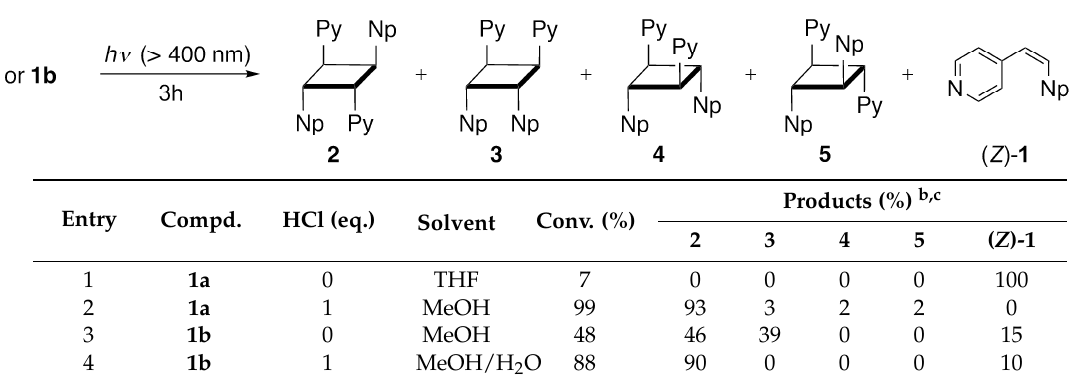
Table 2. Visible-light irradiation of 1a and 1b . a